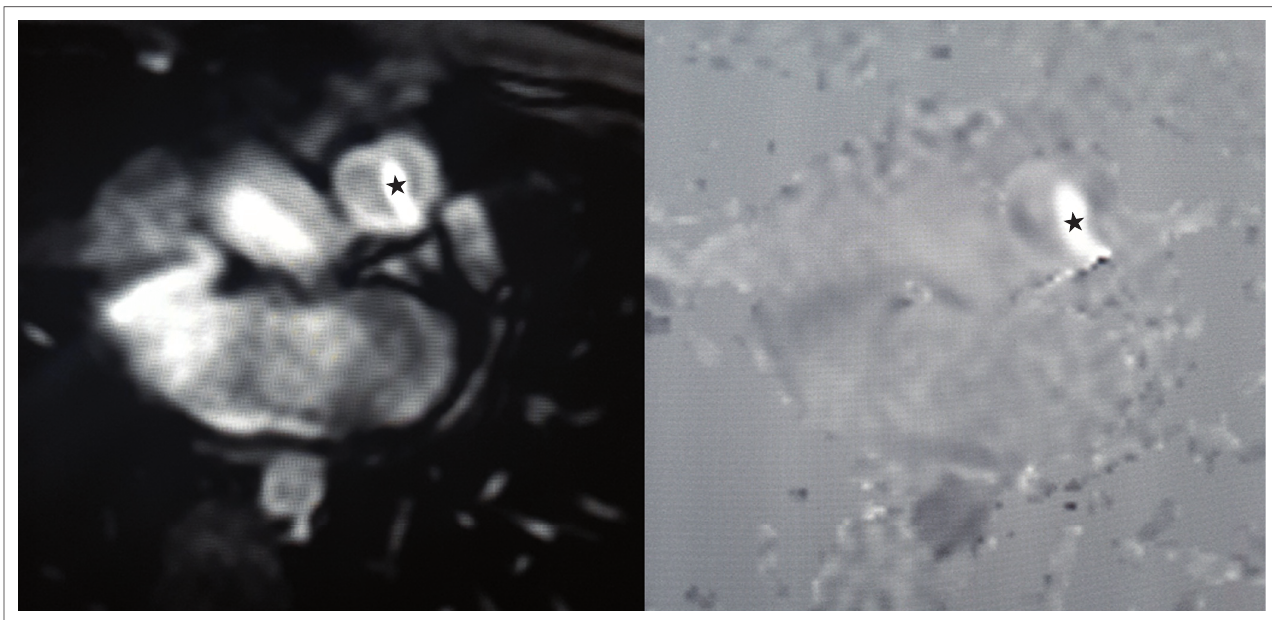
FIGURE 13: Phase contrast images through the pulmonary valve demonstrate pulmonary valve stenosis with flow acceleration ( * ) demonstrated as increased intensity in the pulmonary artery on the magnitude (left) and phase (right) contrasted